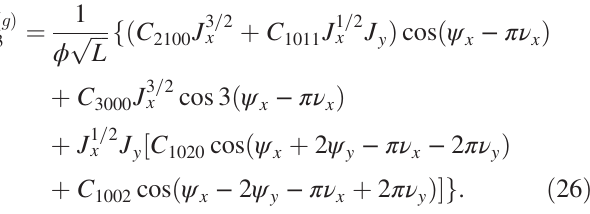
2 ν (left) and 3 ν (right) as a function of the betatron x þ y x